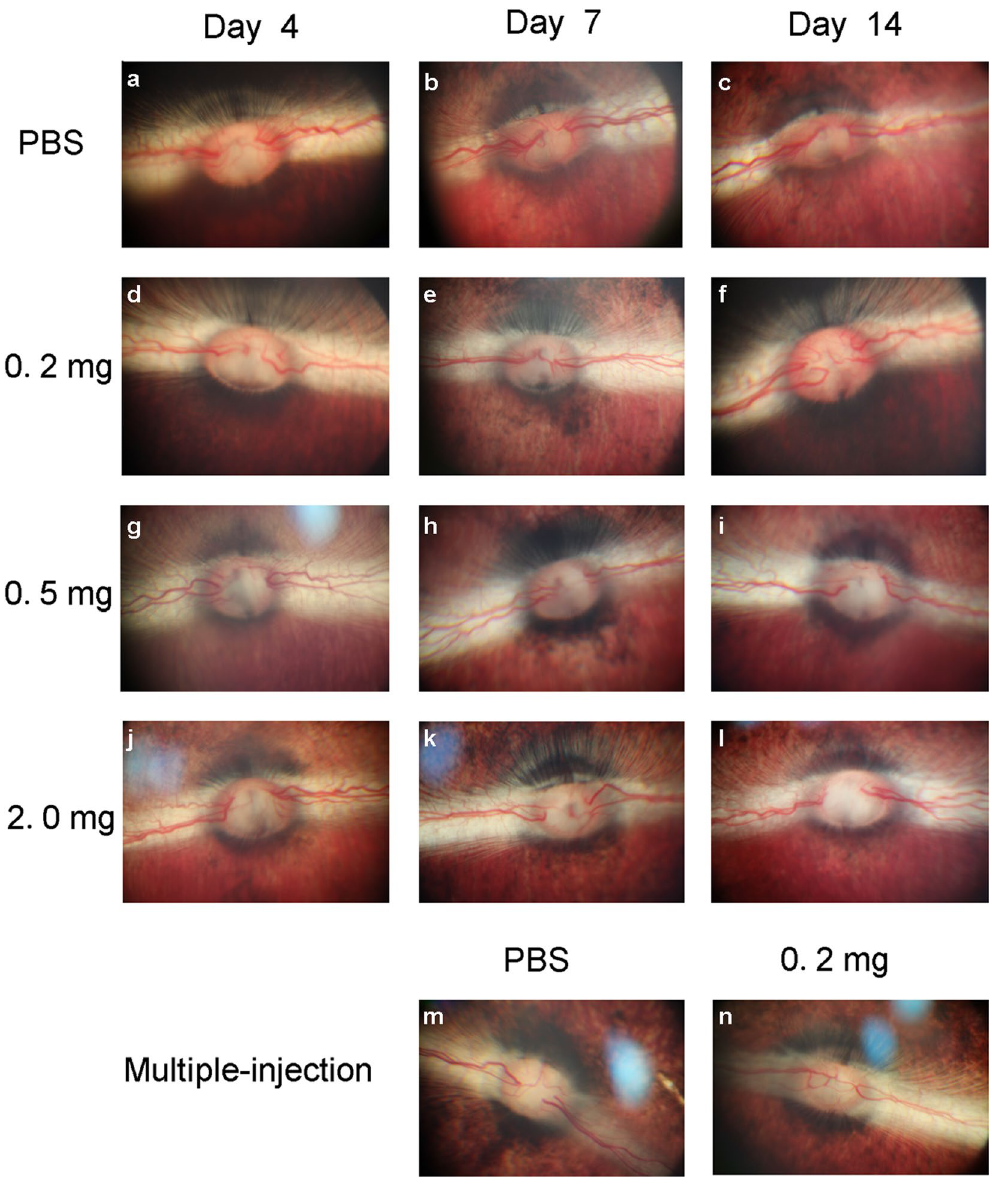
0.5, or 2.0 mg of conbercept ( d–l ) and on the 7 th day after the 6 th multiple injections of 50 μ L PBS ( m ) or 0.2 mg of conbercept ( n ). The results observed in the conbercept-injected groups mimic those in the PBS-injected